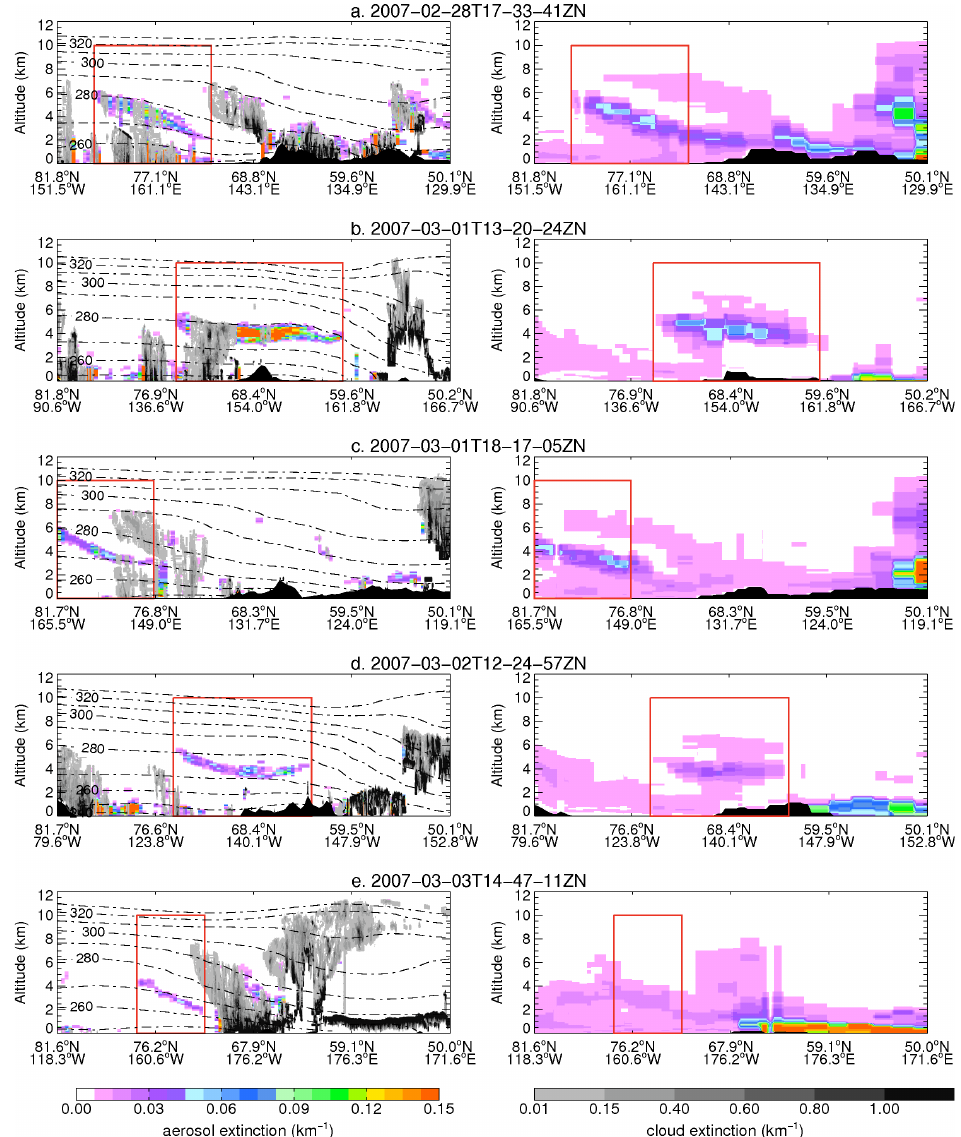
Figure 2. Aerosol extinction comparison between CALIOP (L2 profile data, left) and GEOS-Chem (right). Five scenes were chosen among the 23 East Asian plumes observed by CALIOP during the 28 February–4 March period. Aerosol extinctions are plotted in color and cloud extinctions observed by CALIPSO are in gray. The red box delimits the aerosol layers that have an East Asian origin (see text). Potential temperature contours are shown with dashed-dotted lines on the left panels. The text on top of each panel is the CALIOP file identifier. tain ranges of southeastern Siberia at low